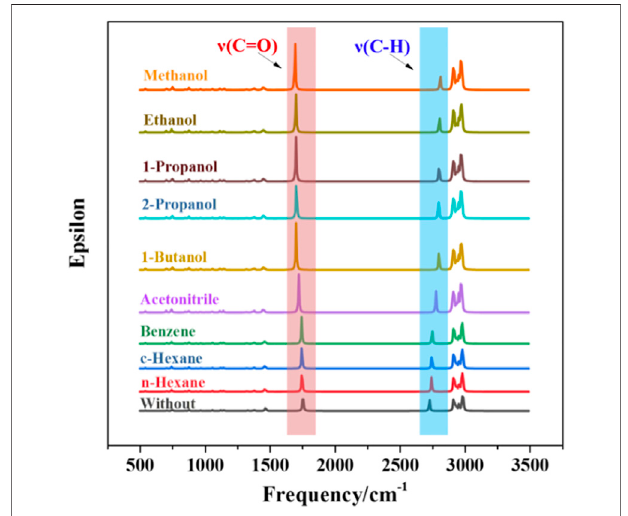
FIGURE 6 | Calculated infrared spectra of 2-Ethylhexanal in different solvents.